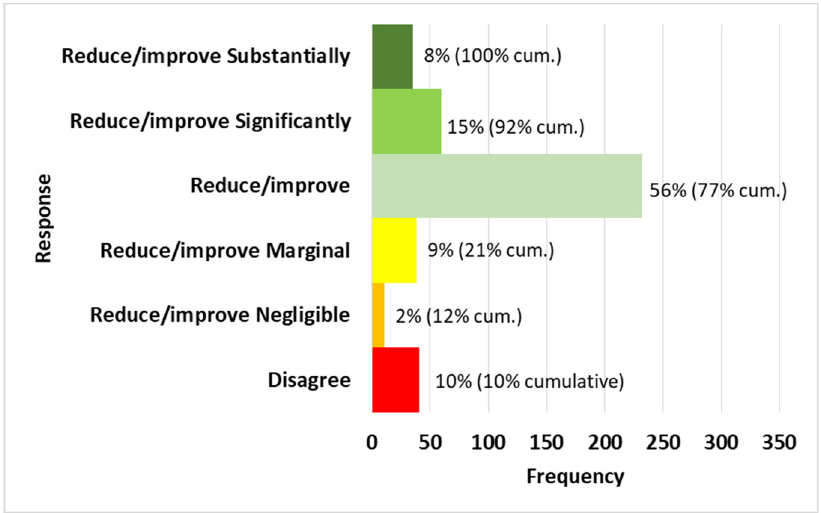
Figure 9. For each level of charges and operational cost–benefit (y-axis), the frequency of responses (x-axis), aggregated across all charges and operational cost benefits.